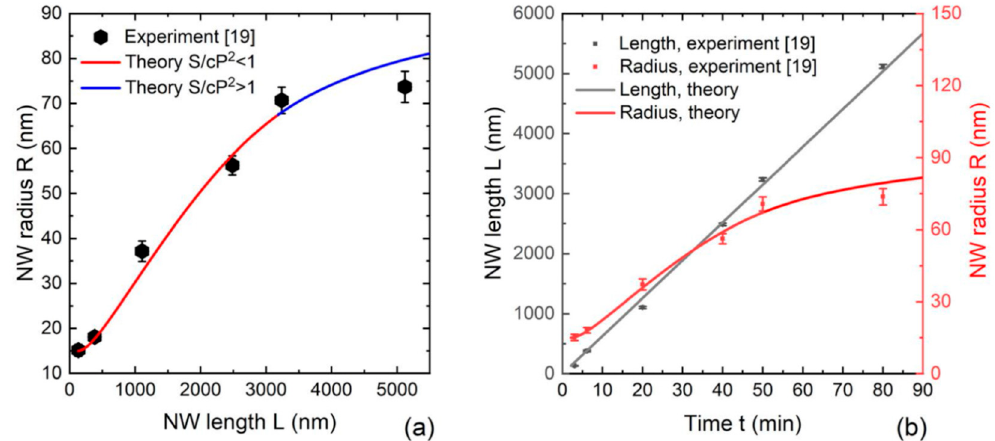
Figure 5. ( a ) Average radius of Ga ‐ catalyzed GaAs NWs versus length [19] (symbols) compared to the solution given by Equation (14). ( b ) Average NW length and radius versus growth time. The red and blue sections in ( a ) correspond to the solutions before and after the full shadowing of the silica mask, respectively.